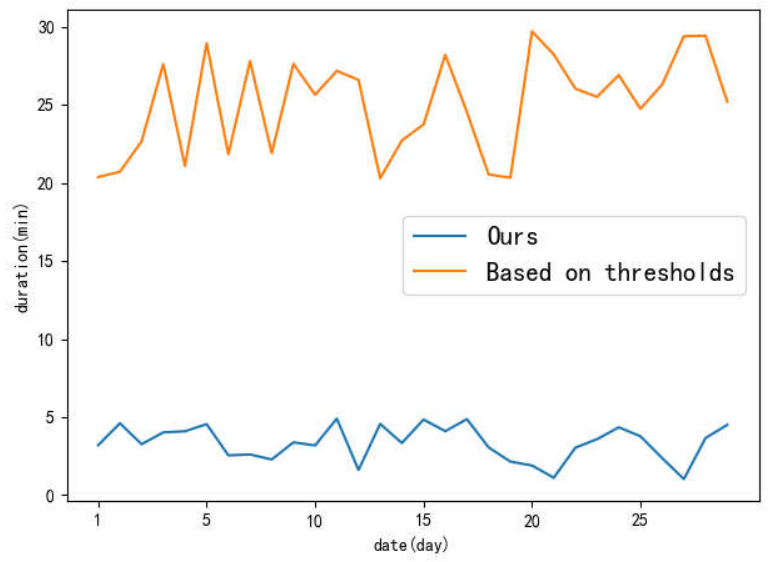
Figure 13. Comparison of the adjustment effect. The X-axis represents the date, and the Y-axis represents the total amount of time that the temperature is abnormal each day.